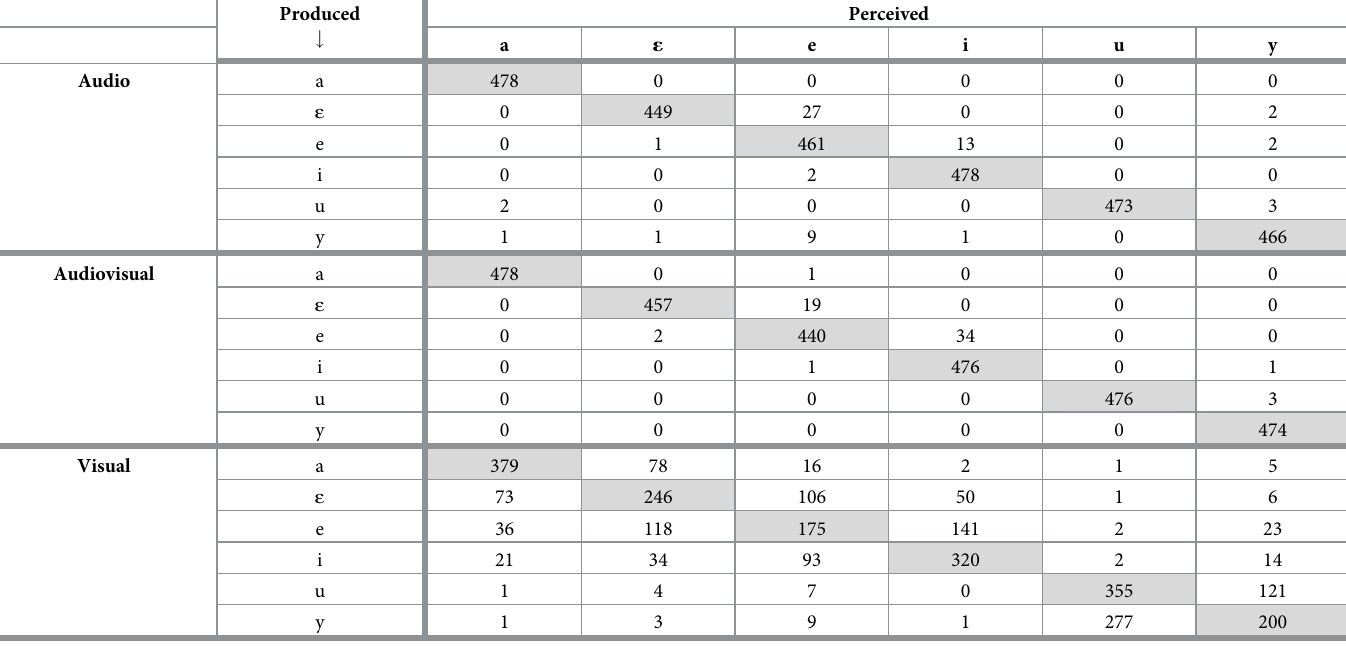
Table 4. Confusion matrices for vowels produced by the sighted speakers in experiment